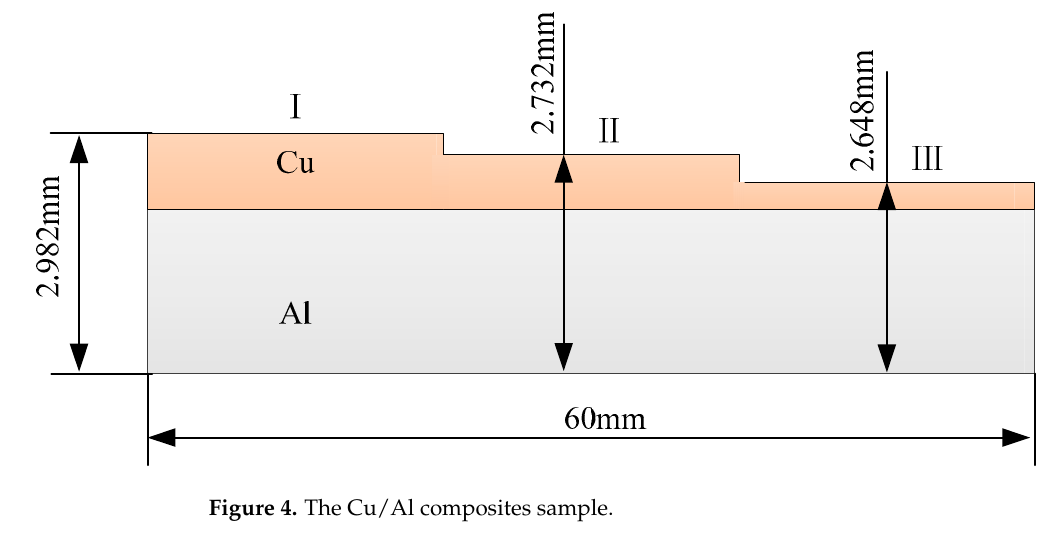
Figure 4. The Cu/Al composites sample.